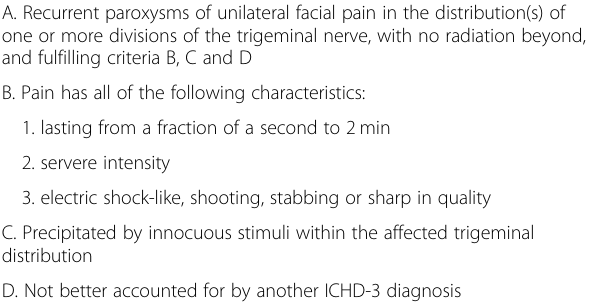
Table 20 Diagnostic criteria in trigeminal neuralgia